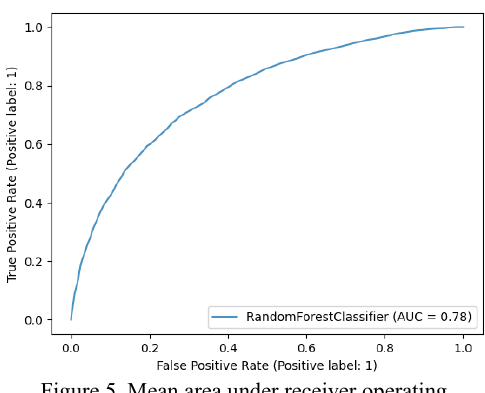
Figure 5. Mean area under receiver operating